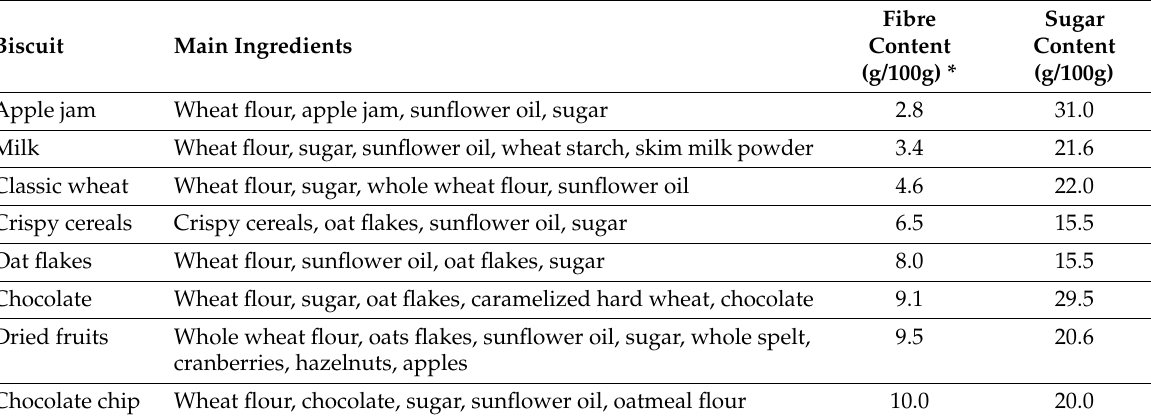
Table 1. Main ingredients, fibre and sugar content of the eight biscuits included in the